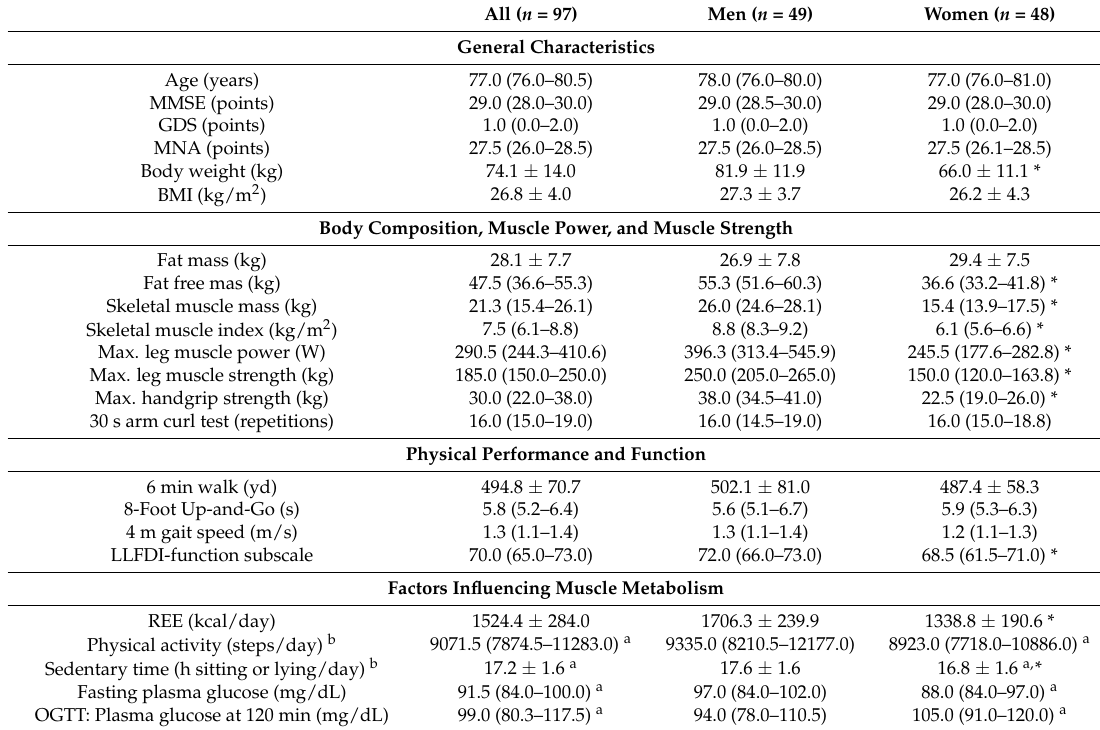
Table 2. Characteristics of the total healthy community-dwelling sample of older adults and subgroups of male and female participants (median (IQR) or mean ± standard